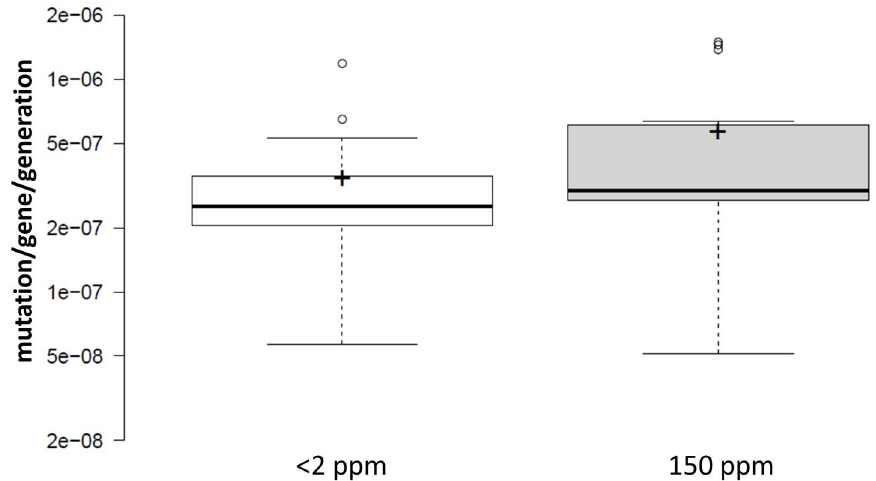
Fig 3. Combined effect of D on the mutation rates measured in one of three genes ( cycA , ackA or galK ) of E . coli . Center lines show the medians; box limits indicate the 25th and 75th percentiles as determined by R software; whiskers extend 1.5 times the interquartile range from the 25th and 75th percentiles, outliers are represented by dots; crosses represent sample means. n = 15 sample points. The means are not significantly different ( t = 1.46, df = 28, P = .16, applying a two-tailed, unpaired